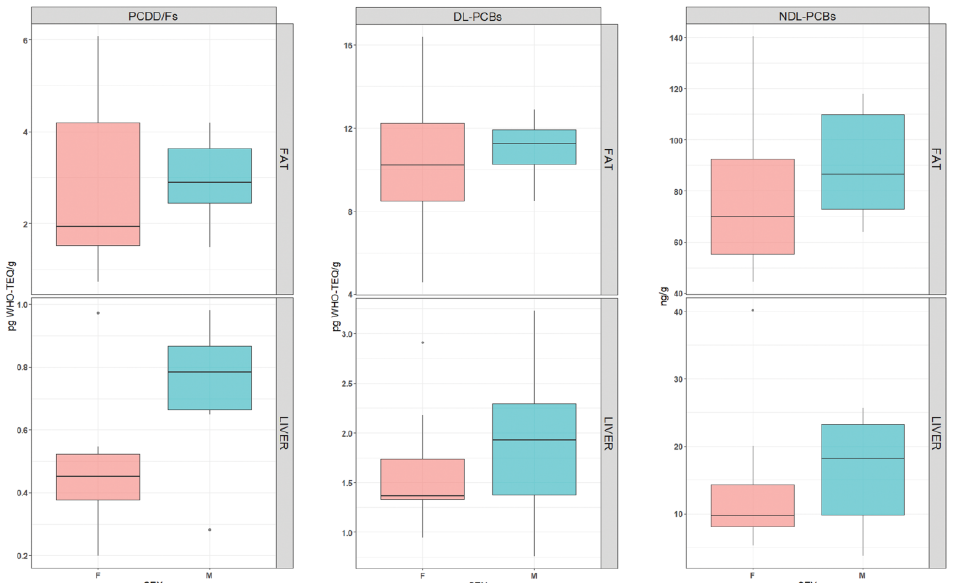
Figure 2. Box-plot showing the comparison of the PCDD/Fs, DL-PCBs (pg WHO-TEQ g − 1), and NDL-PCBs (ng g − 1 ) between male (M -cyan) and female (F–pale red) in fat tissue (on the top) and liver (on the bottom) of sea turtles.